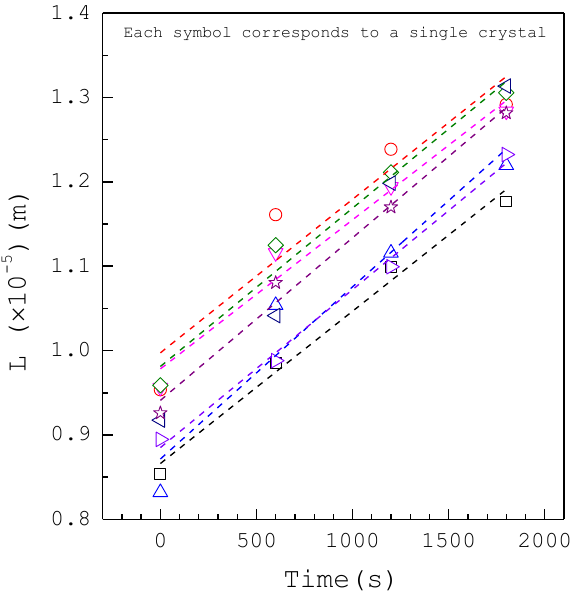
Figure 2. Sizes versus time plots for eight individual crystals for 𝑆 = 13.65 at 37 ℃ without in- hibitors. L represents circular diameter of a crystal. Each line represents the linear regression for a single crystal.